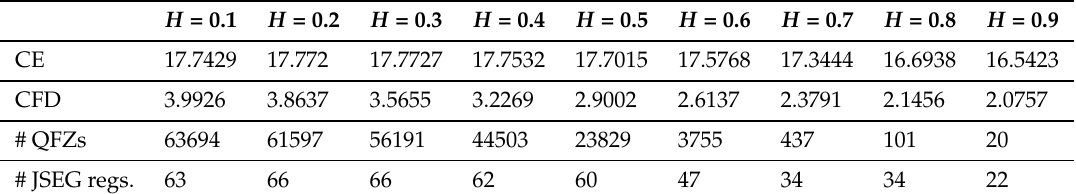
Table 1. Color entropy, color fractal dimension, number of quasi-flat zones and number of regions segmented using JSEG for the nine color fractal images from the data set at [30].